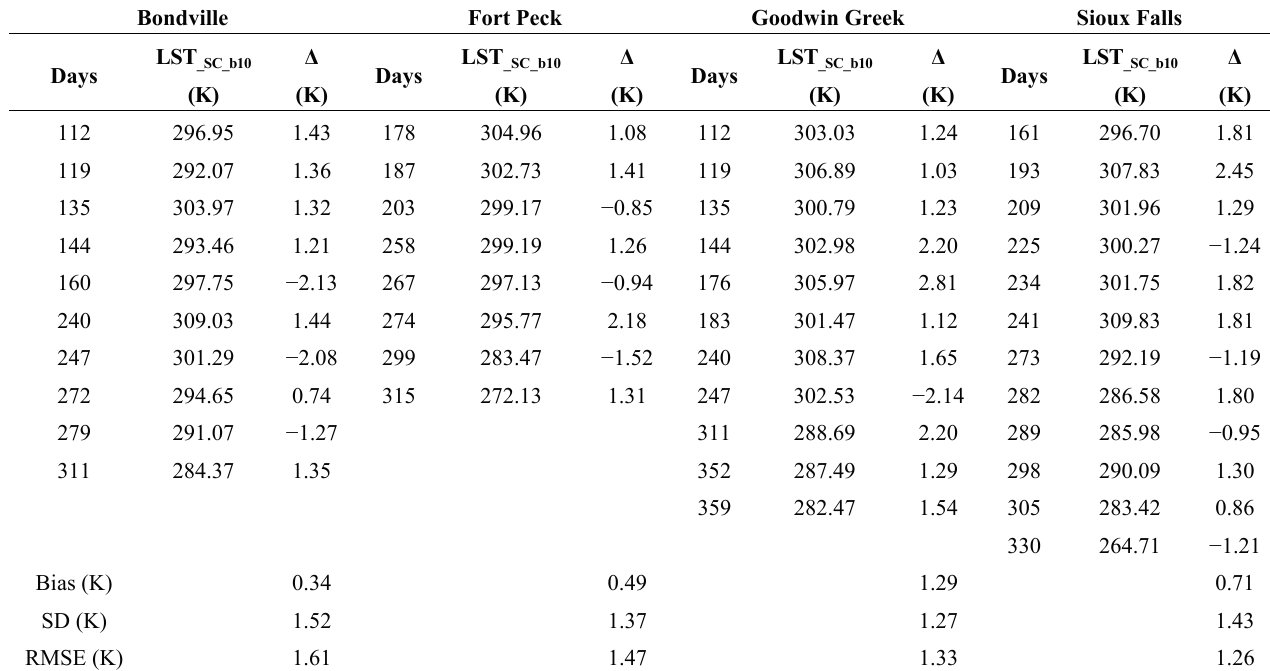
) using SC theory from TIRS band 10 and the _SC_b10 and LST for four selected sites. _SC_b10 _g